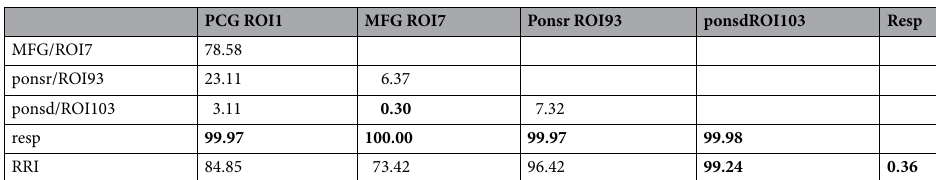
Table 1. Significance of differences between inflows and outflows in terms of percentiles of the distribution obtained by the bootstrap approach (see Methods section) for LA group in the frequency band 0.05–0.15 Hz. Significant differences (marked by bold numbers) are those which exceed the region of 95% of the random distribution of the differences obtained by the bootstrap method. Depending on the sign of the differences between inflows and outflows, they are located below 2.5 and above 97.5 percentile. Flow from the structure marked below the columns to the structures marked beside the rows of the Table.